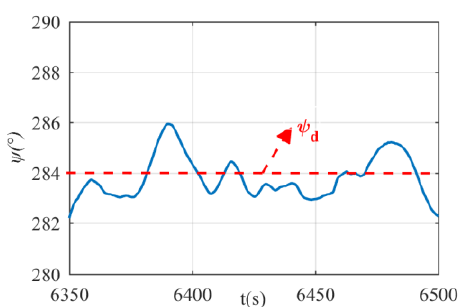
Figure 15. Heading control results. The red line is the heading angle and the red line is the desired heading.